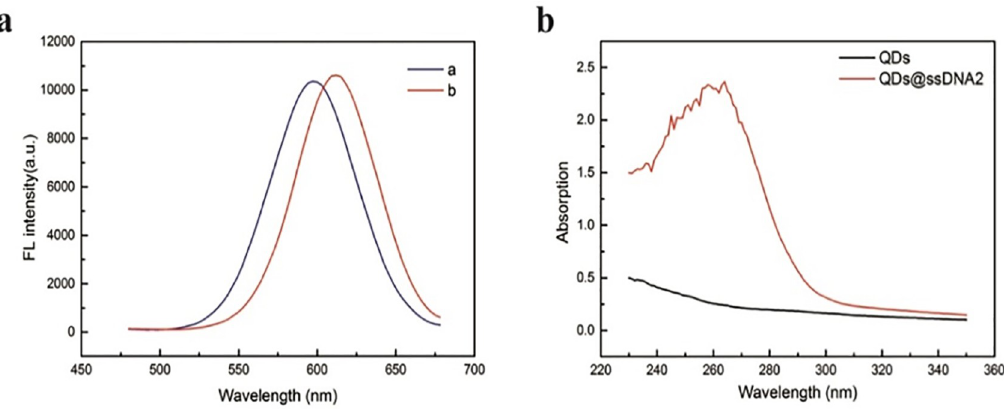
Fig 4. ( a ) Fluorescence spectra of QDs (curve a) and QDs@ssDNA2 (curve b); ( b ) UV-vis absorption spectrum of QDs and